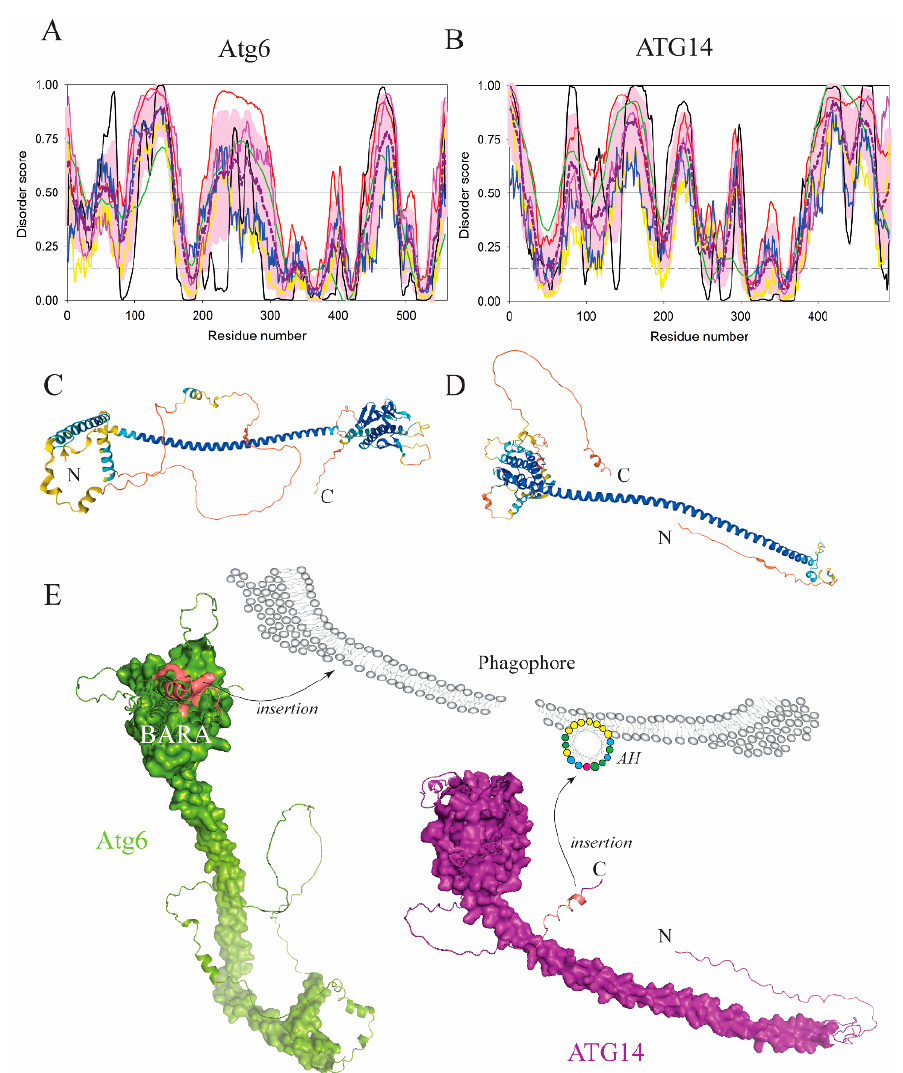
Figure 2. The Atg6–Atg14/BECN1–ATG14 complex in yeast and mammals binds to membranes. ( A,B ) Bioinformatics analysis of the amino acid sequences of the Atg6 in yeast ( S. cerevisiae) and human ATG14 shows that N-terminal coiled-coil domains in each protein are intrinsically disordered. This analysis was conducted using RIDAO web crawler, which was designed for the rapid prediction and comparison of protein disorder profiles. It aggregates the results from a number of well-known disorder predictors: PONDR ® VLXT [21] (black line), PONDR ® VL3 [22] (green line), PONDR ® VLS2 [23] (red line), PONDR ® FIT [24] (pink line), IUPred2 (Short), and IUPred2 (Long) [25,26] (yellow and blue line, respectively). For each query protein, we also generated mean disorder profile (MDP, dashed dark pink line) by averaging the outputs of individual predictors and calculated the corresponding errors (shown as light pink shadow). The outputs of the evaluation of the per-residue disorder propensity by these tools are represented as real numbers between 1 (ideal prediction of disorder) and 0 (ideal prediction of order). A threshold of ≥ 0.5 was used to identify disordered residues and regions in query proteins, whereas residues with disorder scores ranging from 0.15 to 0.5 were considered as flexible. The C-terminal BARA domain in Atg6 contains a disordered loop and the C-terminal BATS region in ATG14 is an IDPR. As per the results of the PONDR ® VLS2 analysis, the overall disorder contents of Atg6 and ATG14 were 55.8% and 61.2%, respectively. According to the accepted practice, proteins can be classified based on their percent of predicted disordered residues (PPDR) as highly ordered (PPDR < 10%), moderately disordered (10%